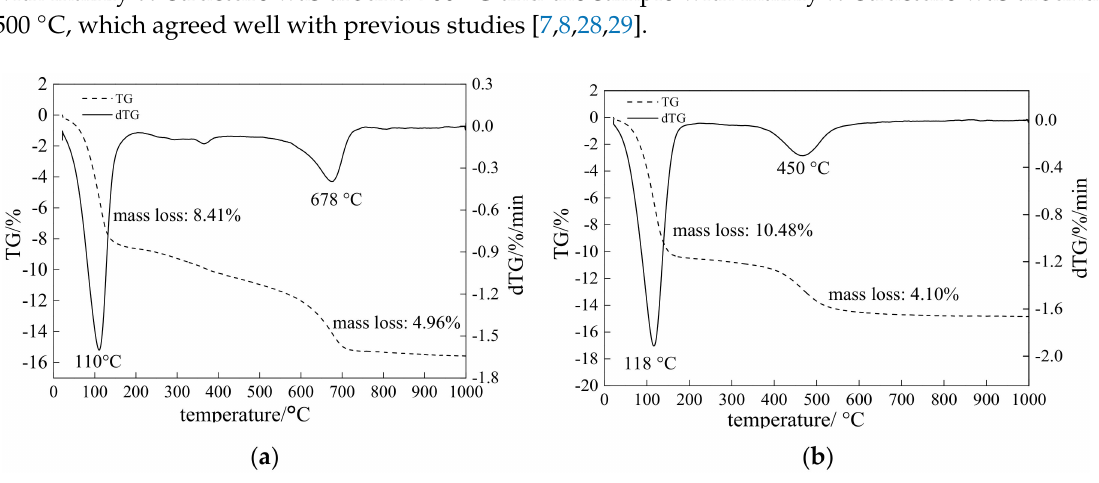
Figure 5. Thermal analysis of ( a ) sample XL_01_B8 with mainly cv structure; ( b ) Sample XL_12_NAu2 with tv